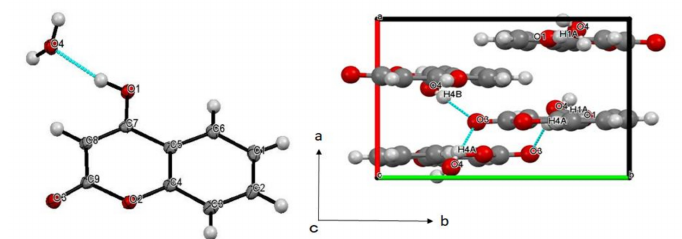
Figure 3. ( left ) Molecular and ( right ) crystal structure of CA1 . Selected bond distances [Å] and angles [ ◦ ]: O1-C7 = 1.3176(16), O2-C9 = 1.3720(15), O2-C4 = 1.3774(16), O3-C9 = 1.2341(17), C7-C8 = 1.3712(18), C8-C9 = 1.4206(17), O1-C7-C8 = 124.65(12), O1-C7-C5 = 115.78(11), C9-O2-C4 = 121.05(10), O2-C9-C8 = 119.29(11), O3-C9-O2 = 114.55(11), O3-C9-C8 =